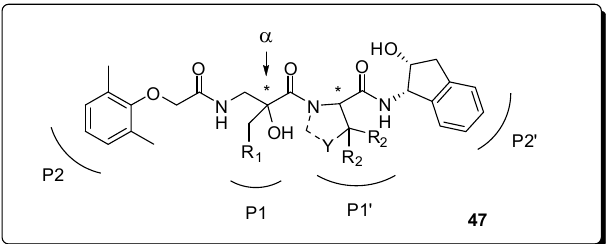
Figure 15. Generic structure of the designed α -substituted norstatine inhibitors with